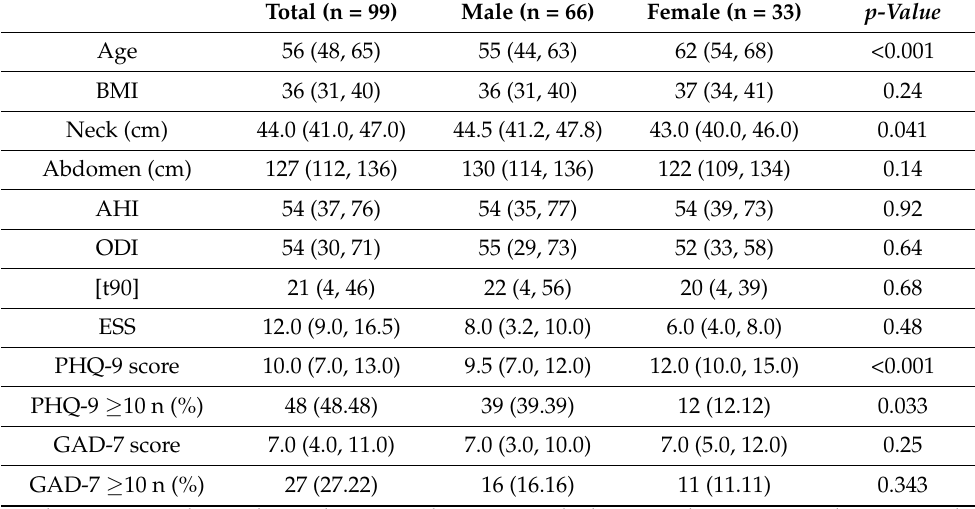
Table 1. Description of a study group at baseline.